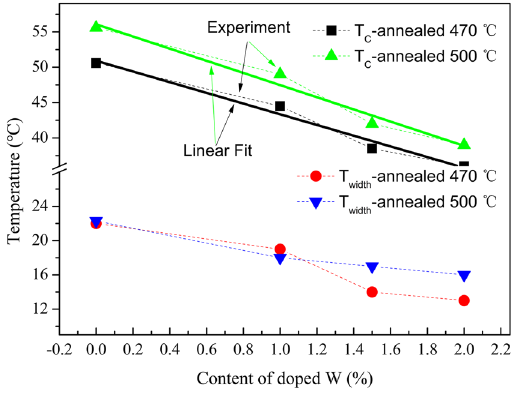
Figure 6. The MIT switching temperature (T c ) and width of the transmittance switching relaxation (T width ) of samples with different W doped content, and annealed at 470 and 500